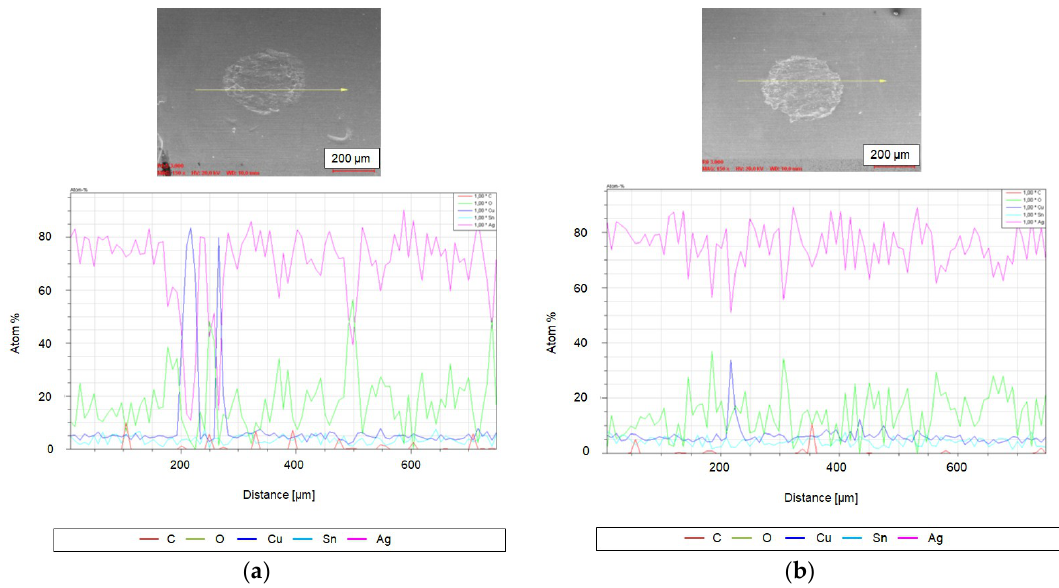
Figure 6. Scanning electron microscope (SEM) images of the wear scars and energy-dispersive X-ray spectroscopy (EDS) in X-ray Linescans mode across the contact area after 3000 fretting cycles: ( a ) on the sphere; ( b ) on the plane.